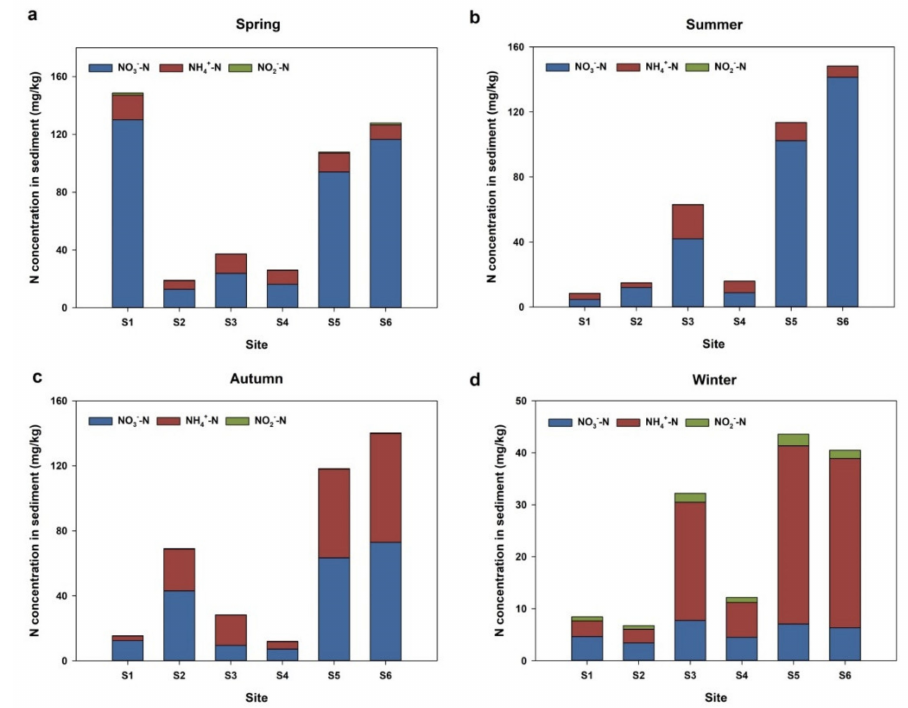
Figure 2. Spatial distribution of different species of inorganic nitrogen (mg/kg) in summer ( a ), autumn ( b ), winter ( c ), and spring ( d ) in surface sediments of the QCS Reservoir,